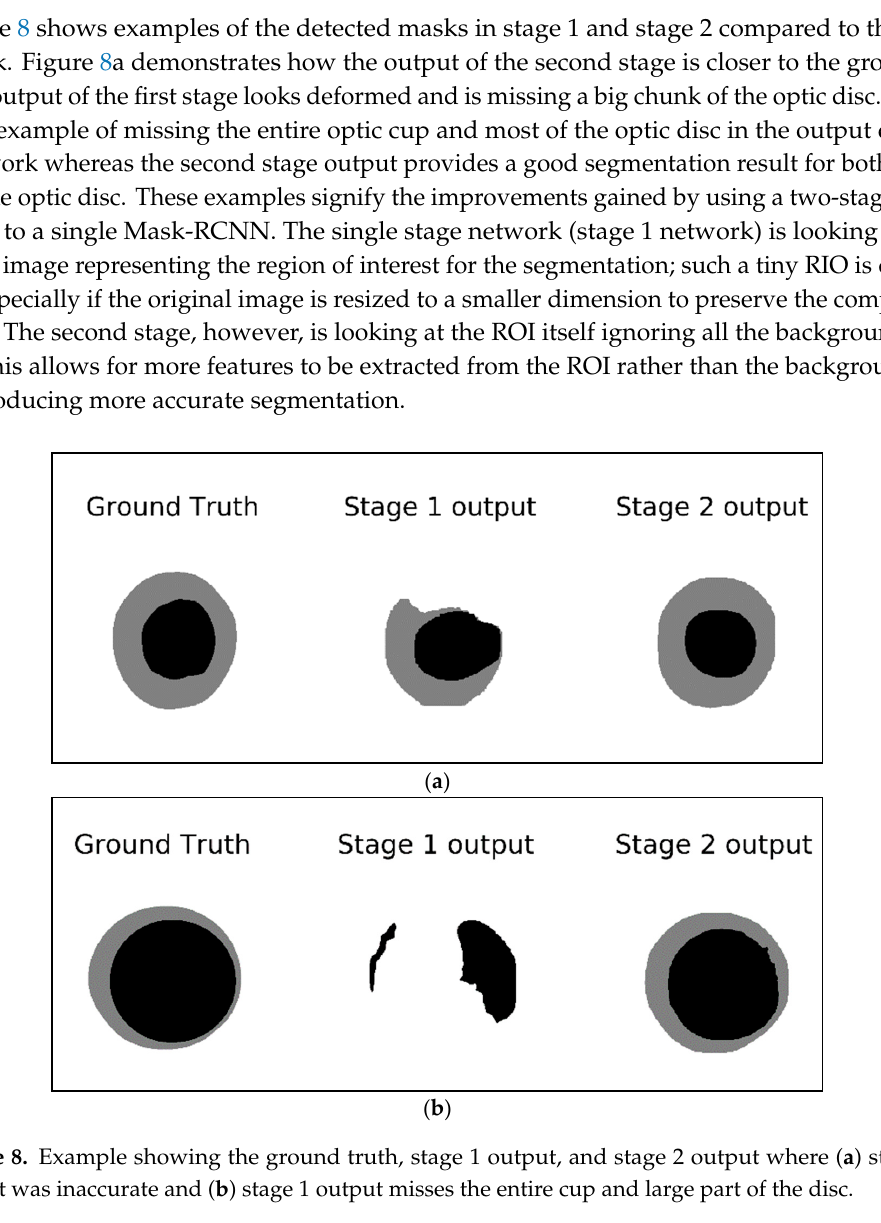
Table 4. Comparing segmentation accuracy.